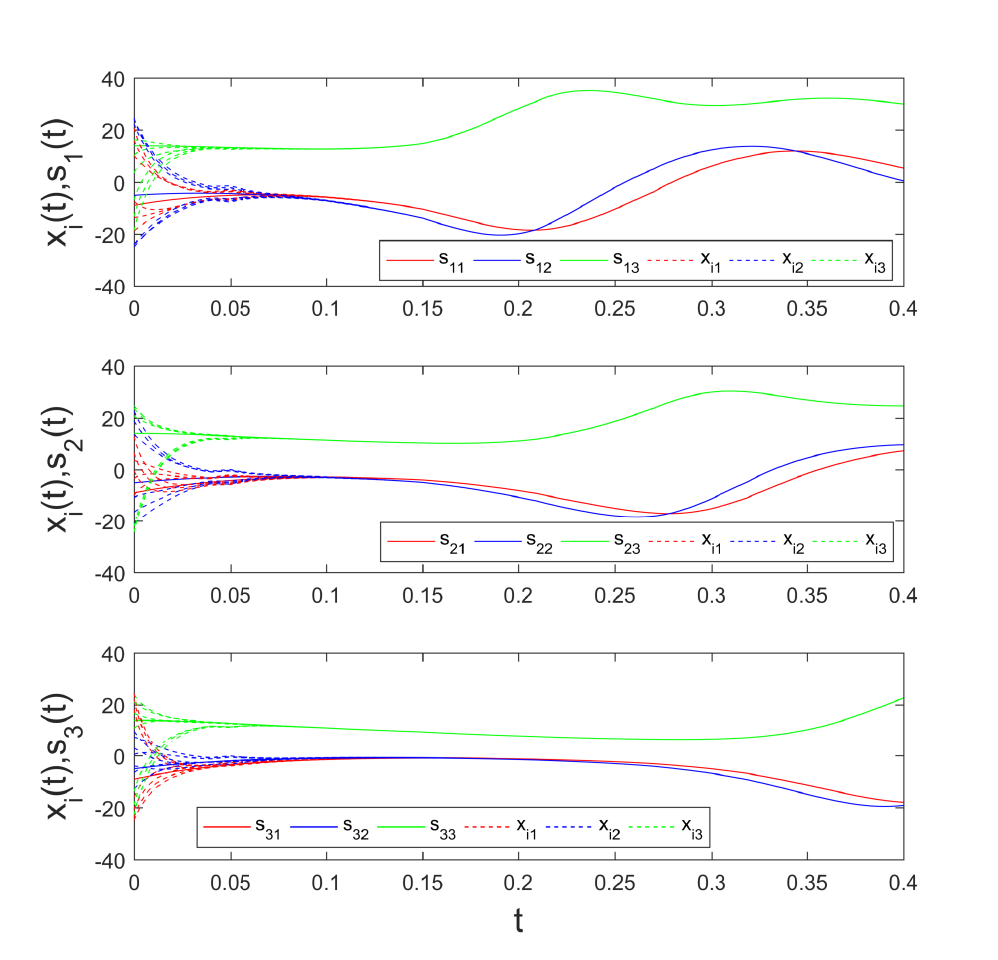
Figure 4. The top shows the trajectories of x ij and s 1 j , i = 1,2, · · · ,6, j = 1,2,3. The middle shows the trajectories of x ij and s 2 j , i = 7,8, · · · ,12, j = 1,2,3. The bottem shows the trajectories of x ij and